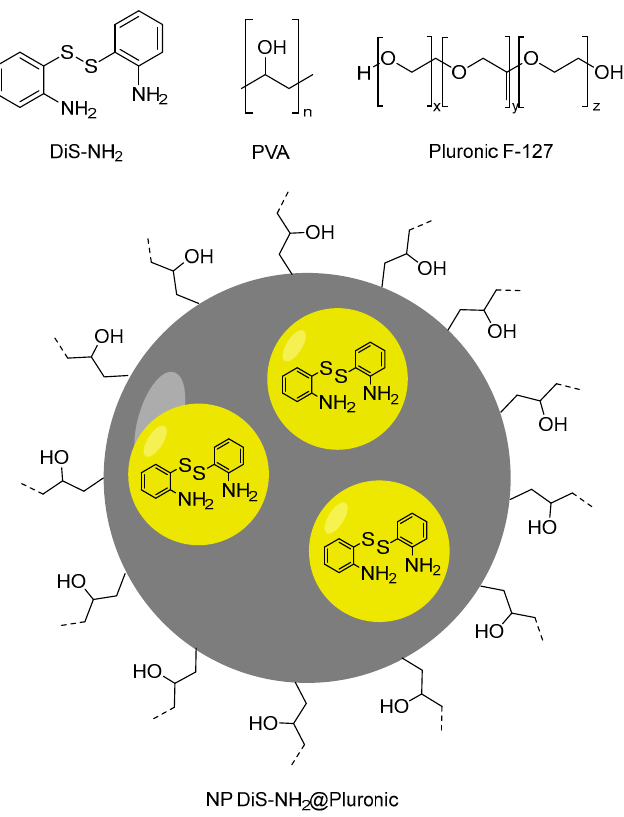
Figure 1. Structure of the bioactive compound (DiS-NH 2 ), the encapsulating polymer (Pluronic F-127), and the matrix (PVA). NP DiS-NH 2 @Pluronic is the proposed nanostructure of the synthesized system. The stirred solution of Pluronic F-127 ® was cooled with ice, and the DiS-NH 2 solution was added dropwise through a 0.45 µ m nylon membrane. The resulting solution was stirred for 10 min. The PVA solution was then added dropwise and dialyzed for 10 min with type II water using a membrane with a 12,000 Da cut-off (dialysis tubing cellulose membrane, Sigma-Aldrich, Steinheim, Germany) to remove the amount of DiS-NH 2 that was not encapsulated. This solution was frozen with liquid nitrogen to keep the particle size in the nanoscale. This frozen solution, which contained the functionalized nanoparticles, was lyophilized using a LyoAlfa 15 Telstar ® machine to produce a fine yellow powder. This method was repeated several times to obtain sufficient material for the field experiments. The percentage of encapsulation was determined by dissolving the NPs (1 mg) in acetoni- trile (1 mL). The mixture was agitated in a vortex to break up the particles and release DiS-NH 2 . The sample was filtered through a 0.22 µ m nylon membrane, and the solution was analyzed using high-performance liquid chromatography (HPLC) to determine the concentration of DiS-NH 2 within the nanoparticles. The UV absorbance was measured with a detector with a wavelength of 260 nm. The HPLC system was VWR Hitachi Chromaster (VWR International, Radnor, PA, USA) with a model 5430 DAD, a model 5310 column oven, a model 5260 autosampler, and a model 5110 solvent pump. A Rever ® C18 column (25 × 4.6 mm; Phenomenex, Macclesfield, UK) with a 5 µ m pore size was utilized. Solvents were obtained from VWR and filtered using a Durapore ® 0.4 µ m filter membrane (3 M, Saint Paul, MN, USA) before use in the HPLC apparatus. The retention time of DiS-NH 2 was 4.67 min in isocratic mode (30% MeOH: H 2 O). The areas of the peaks were converted to concentrations using a calibration curve obtained from previously reported methods